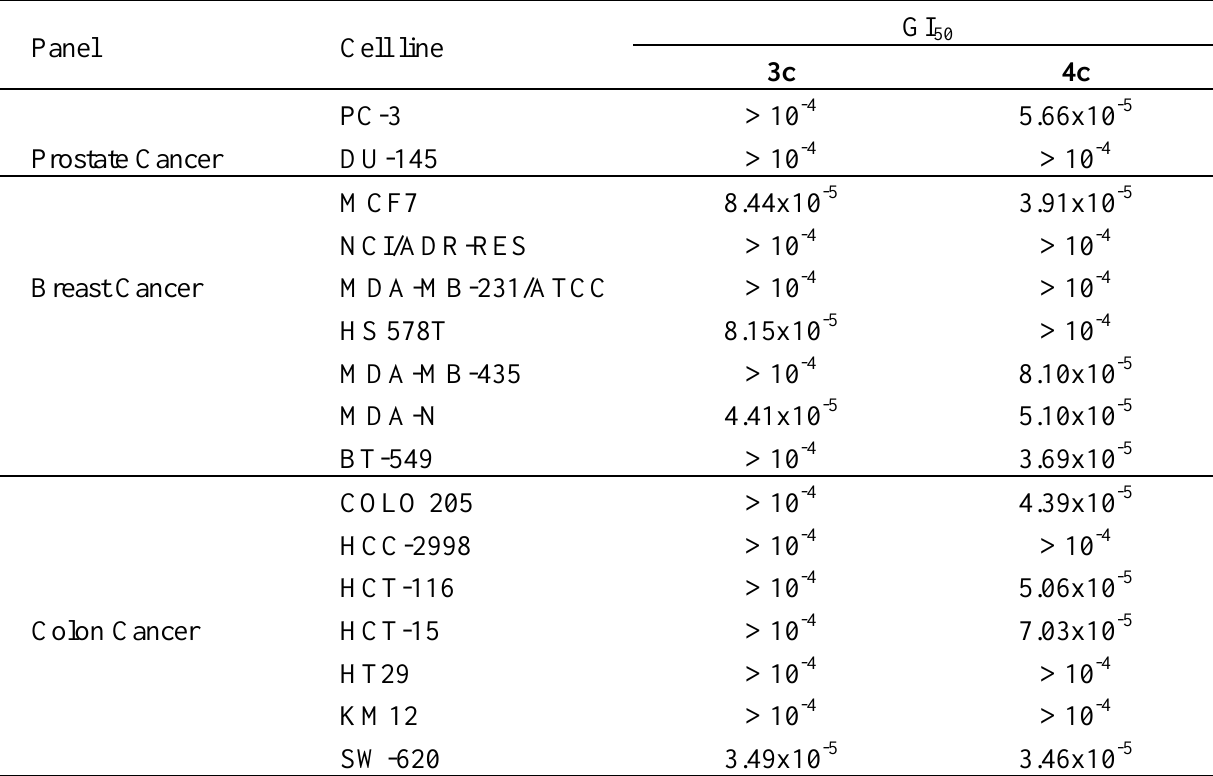
Table 4 . Comparative in vitro anti-tumour activity of diastereoisomers 3c and 4c against prostate, breast and colon cancer cell